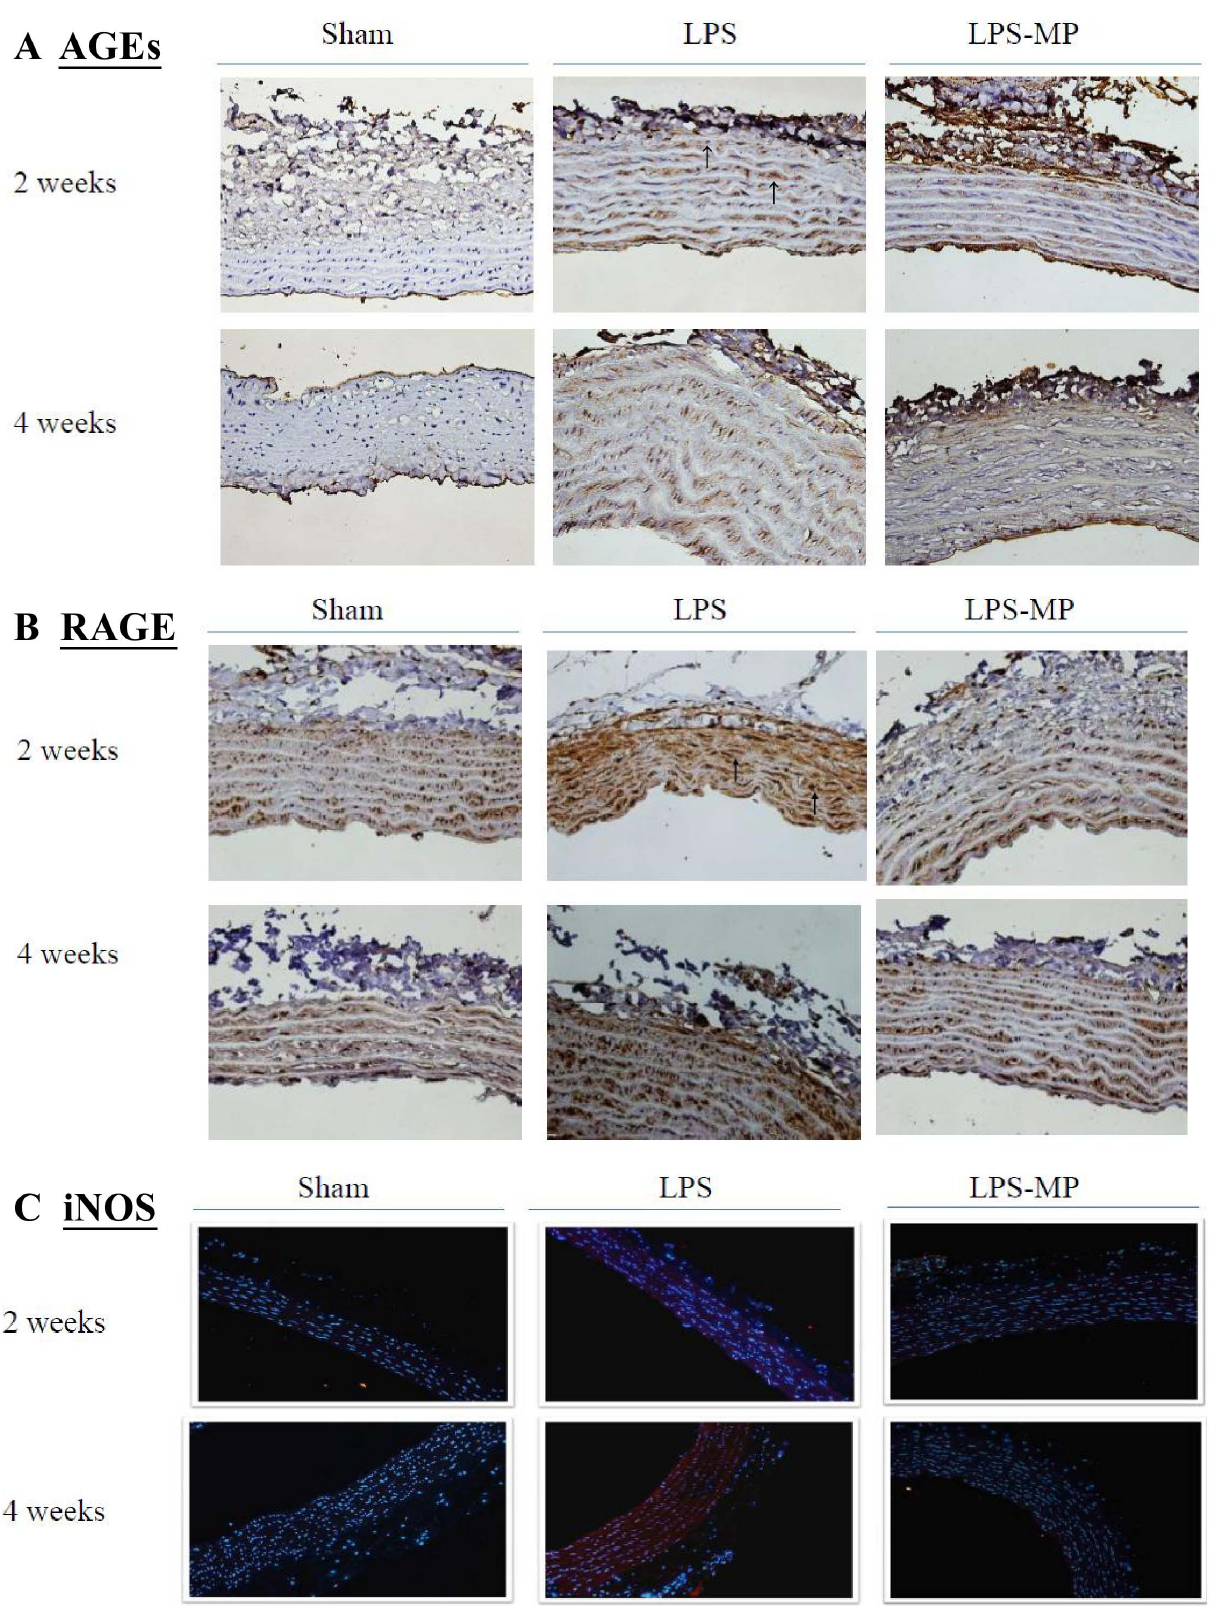
Figure 2. Effects of LPS and MP on the expression of AGEs (A), RAGE (B), and iNOS (C) in the aortas. AGEs and RAGE expressions were probed using immunohistochemical staining (400x). The arrows indicated the sites of antibody staining. iNOS expression (red color) was explored